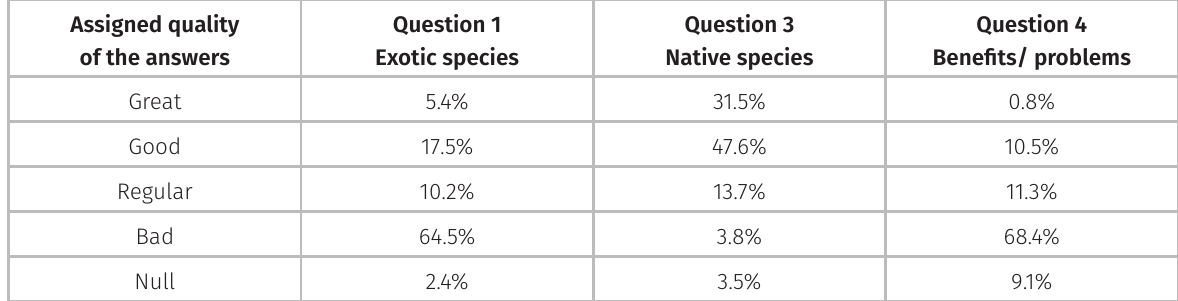
Table I. Classification of the students’ answers regarding the concept described in questions 1, 3, and 4 of the subjective questionnaire. The results from the other questions were discussed in the text. Assigned